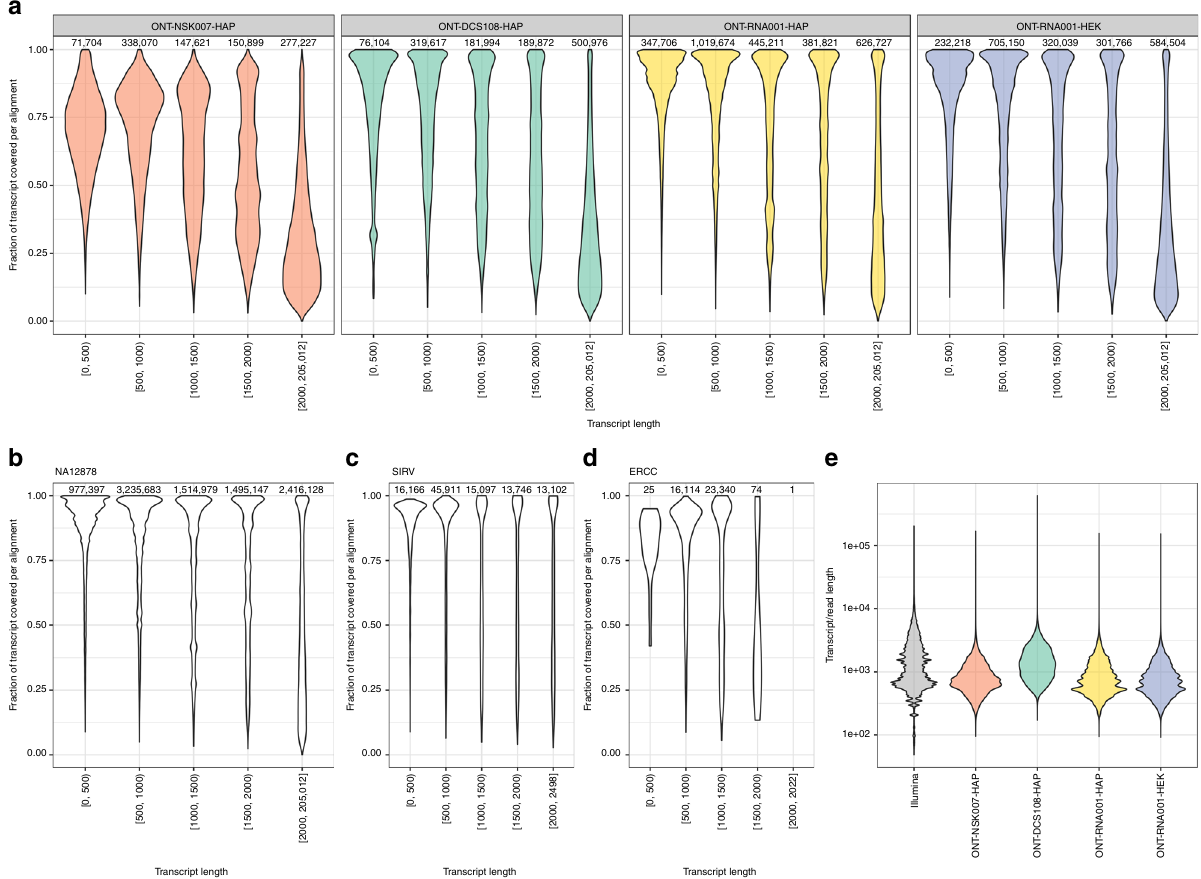
Fig. 3 Transcript coverage fraction by individual reads. a Distribution of coverage fractions of transcripts by individual reads, for each of the four ONT data sets, strati fi ed by the length of the target transcript. The target transcript was selected to maximize the coverage fraction, among all reported long enough alignments (see Methods), and thus the reported coverage fractions represent upper bounds of the true ones. The number above each violin indicates the number of processed alignments to transcripts in the corresponding length category. b – d Distribution of coverage fractions of transcripts by individual reads for the NA12878, SIRV, and ERCC data sets. e Observed distribution of raw read lengths for reads with at least one genome alignment (for ONT data sets) and expected distribution of transcript molecule lengths based on annotated transcript lengths and estimated abundances in the Illumina